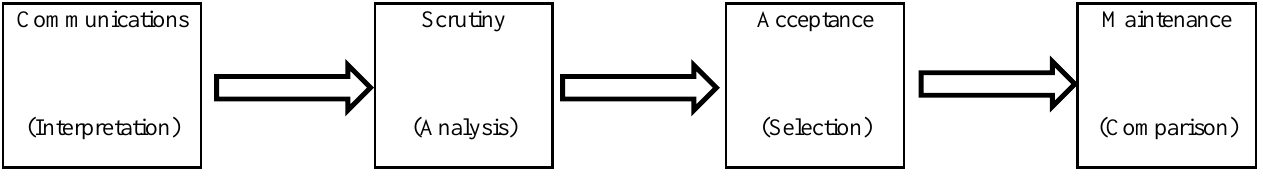
Fig. 1. Cycle of brand promise delivery (Samiei nasr et al.,